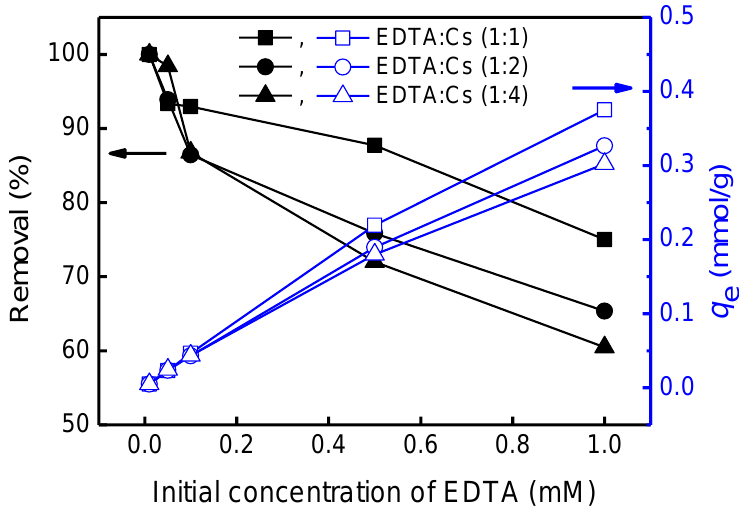
Figure 9. Changes in removal efficiency and adsorption capacity of EDTA using AERs in various ratios of EDTA and Cs (1:1 ( ■ , □), 1:2 (●, ○ ), and 1:4 ( ▲ , △ )) with various initial EDTA concentrations (0.01–1 mM). [AERs] = 2 g/L; pH = 7; adsorption time = 5 h.